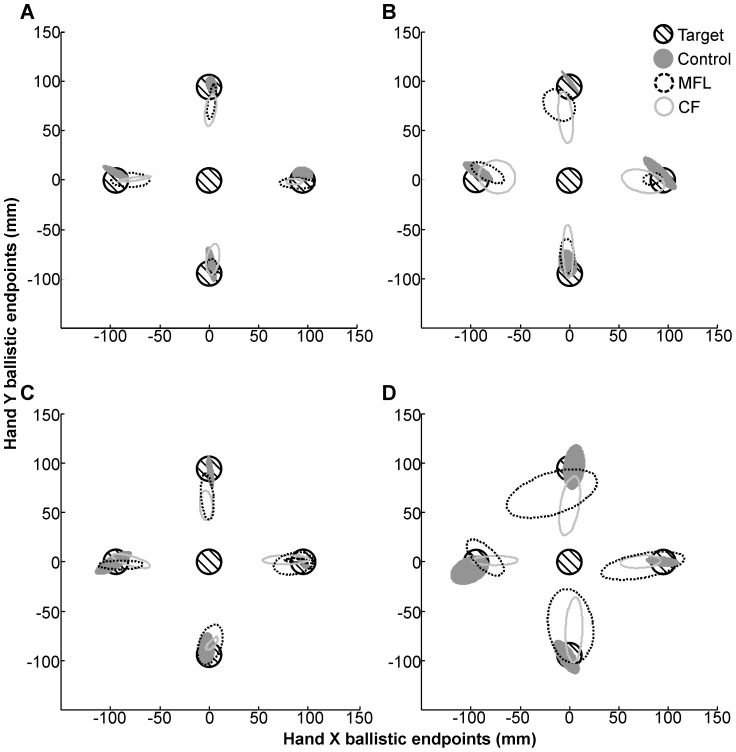
Individual hand endpoint ellipses for MFL, CF, and a typical control subject.Hand movement endpoints to four peripheral targets from the home target in (A) Vertical (B) Vertical Rotated (C) Horizontal (D) Horizontal Rotated. Both hands were pooled for MFL and CF. Open and filled ellipses represent 95% confidence intervals for patients and a typical control, respectively. Circles with cross-hatching represent starting and ending target location. Note that the systematic undershoot seen in both patients is not seen in the horizontal conditions in the + y direction towards the monitor.